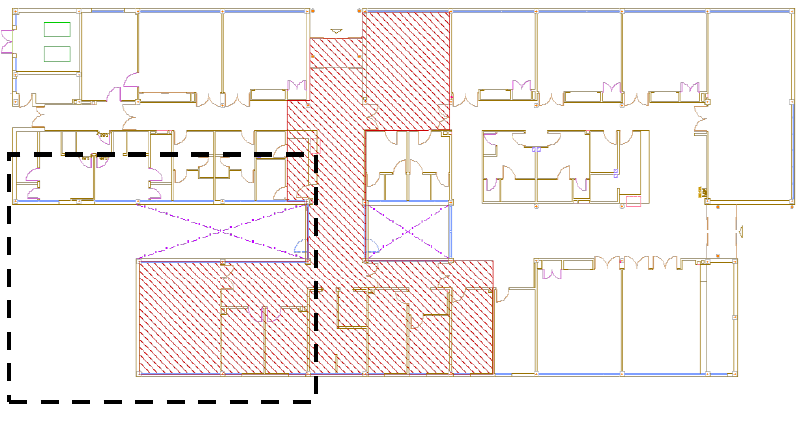
Figure 5. General view of building roof (dotted line indicating green roof affected area).